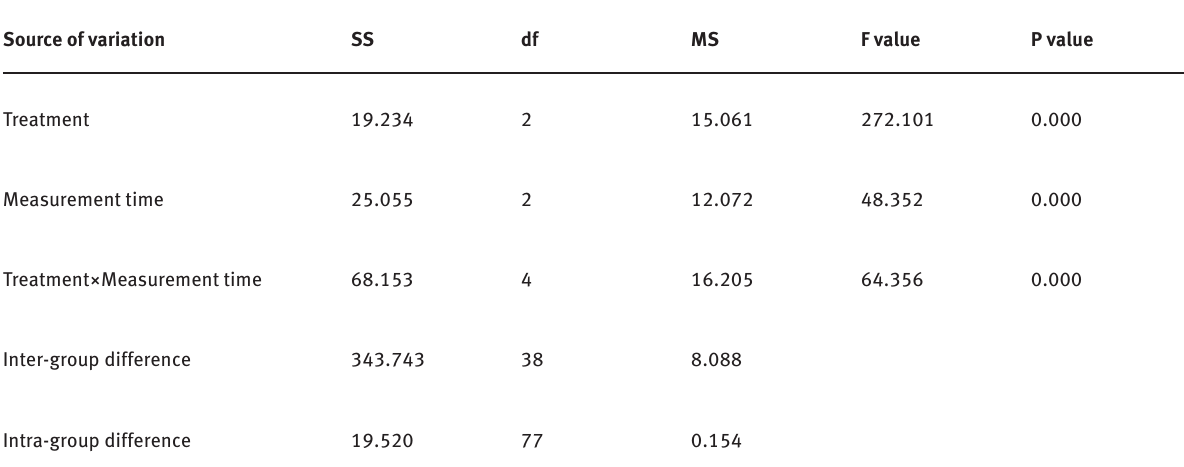
Table 2: Variance analysis of m value of the patients in the three groups at different times